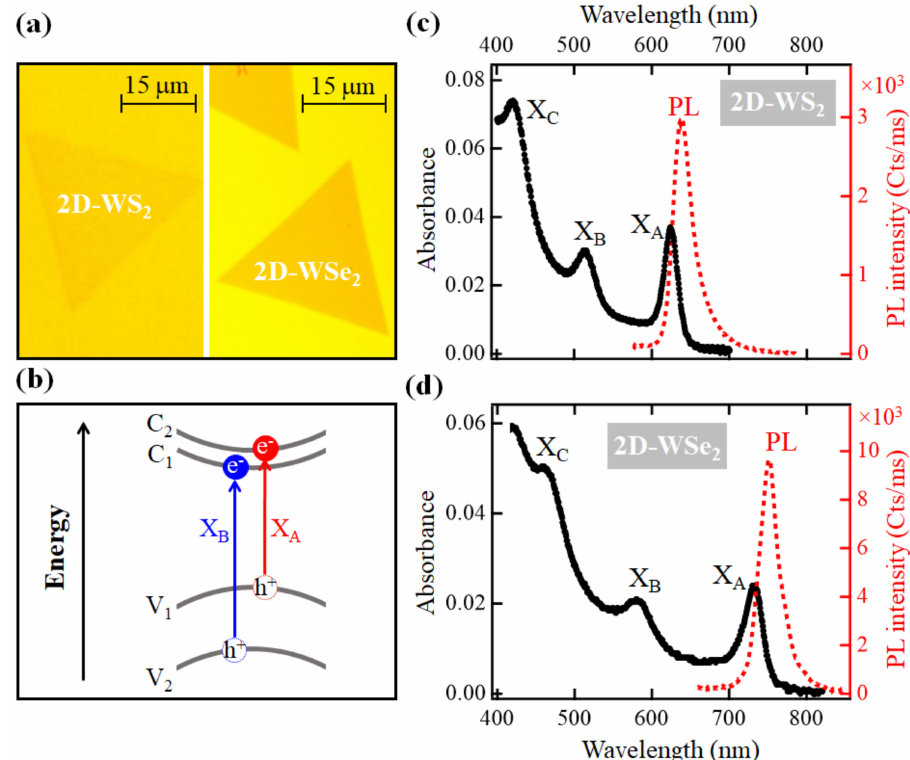
Figure 1. ( a ) Optical images of the studied monolayer single crystals of 2D-WS 2 and 2D-WSe 2 ; ( b ) depiction of the excitonic transitions X A (V 1 → C 2 ) and X B (V 2 → C 1 ) between the spin-orbit split levels at the VB and CB in 2D-TMDs; ( c ) steady-state absorption spectrum measured at the 2D-WS 2 monolayer crystal shown in ( a ). The dotted line is the PL spectrum measured following excitation at ~400 nm; ( d ) steady-state absorption spectrum measured at the 2D-WSe 2 monolayer crystal shown in ( a ). The dotted-plot is the PL spectrum measured following excitation at ~400